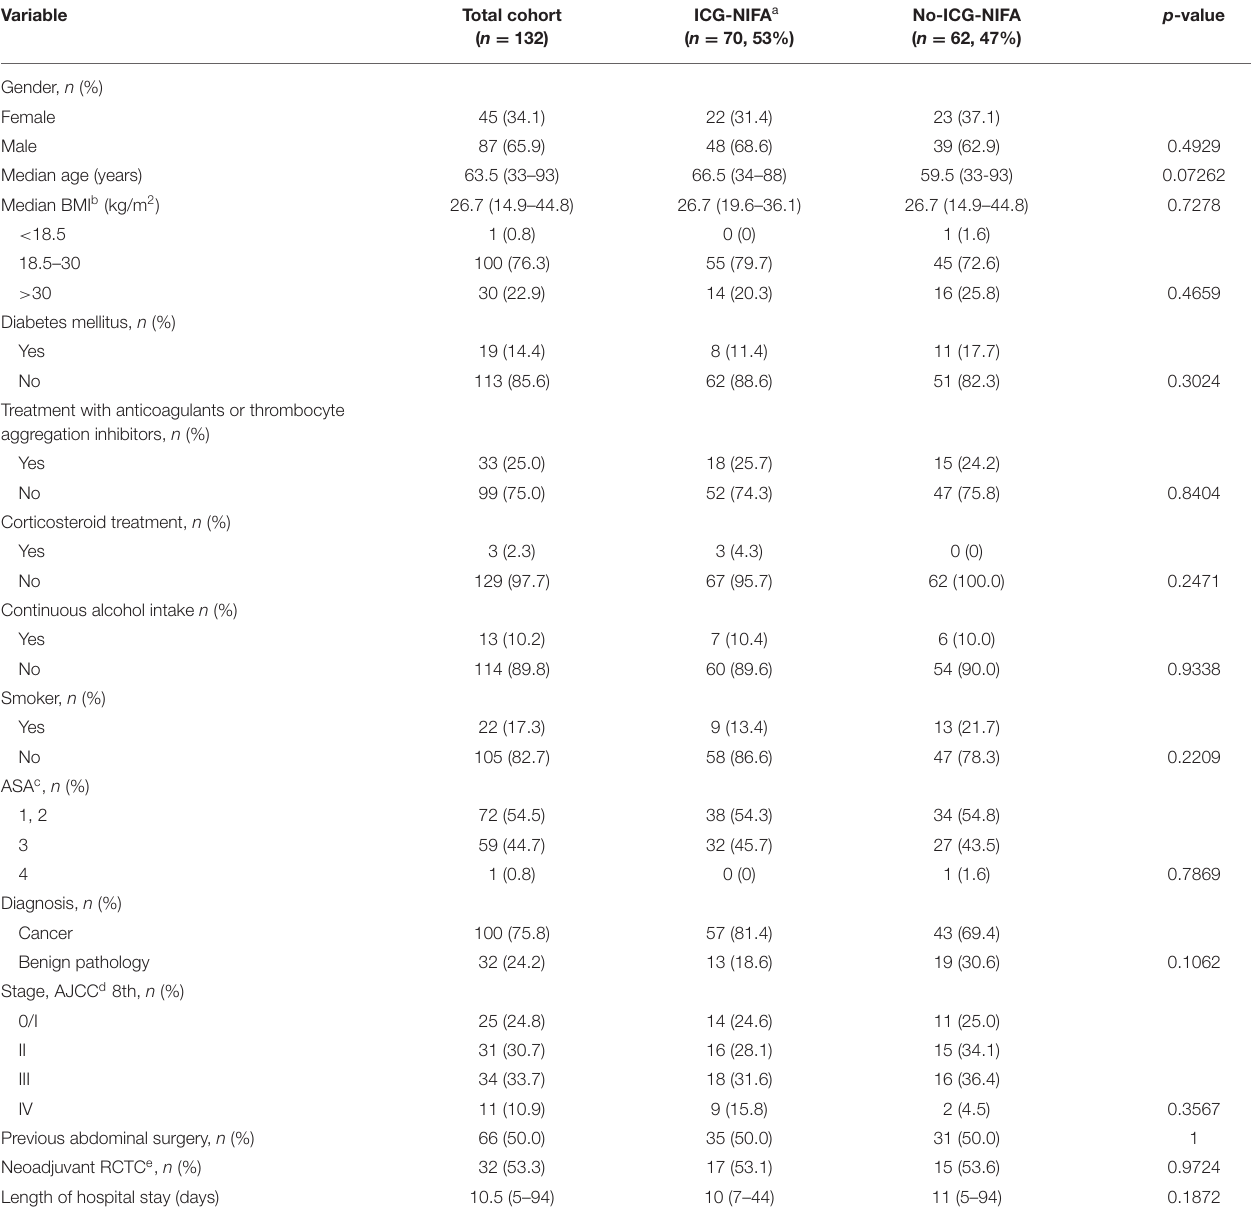
TABLE 1 | Patient demographic and clinical characteristics in the ICG-NIFA and no-ICG-NIFA groups.